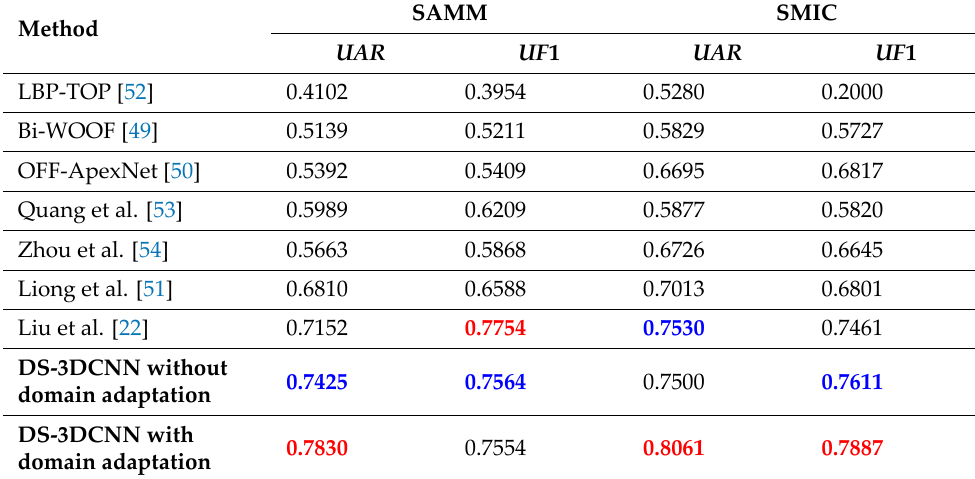
Table 4. Comparison of UAR and UF 1 scores between two proposed models (DS‑3DCNN without domain adaptation and DS‑3DCNN with domain adaptation) and state‑of‑the‑art models. The best results are highlighted in red and the second‑best results are highlighted in